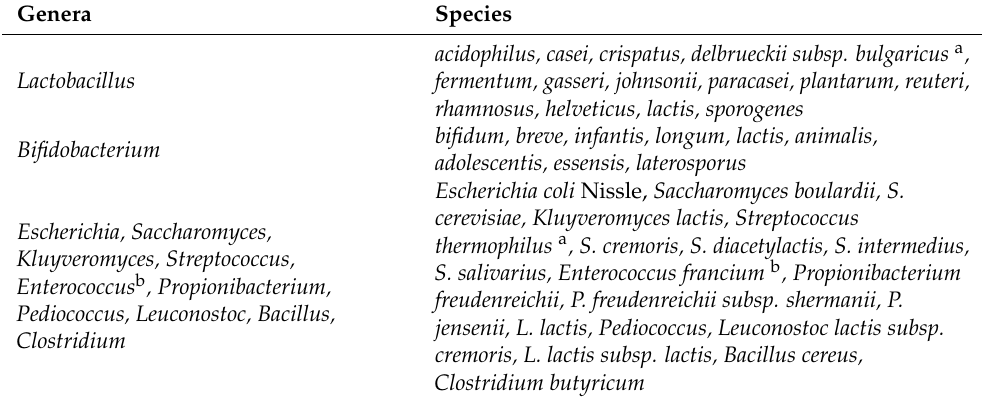
Table 2. Microorganisms (bacteria and some yeast) that are used as